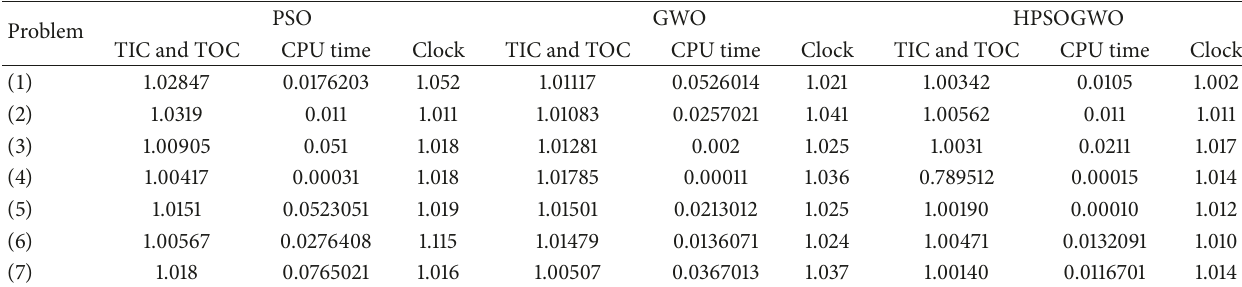
Table 10: Time-consuming results of unimodal benchmark functions.